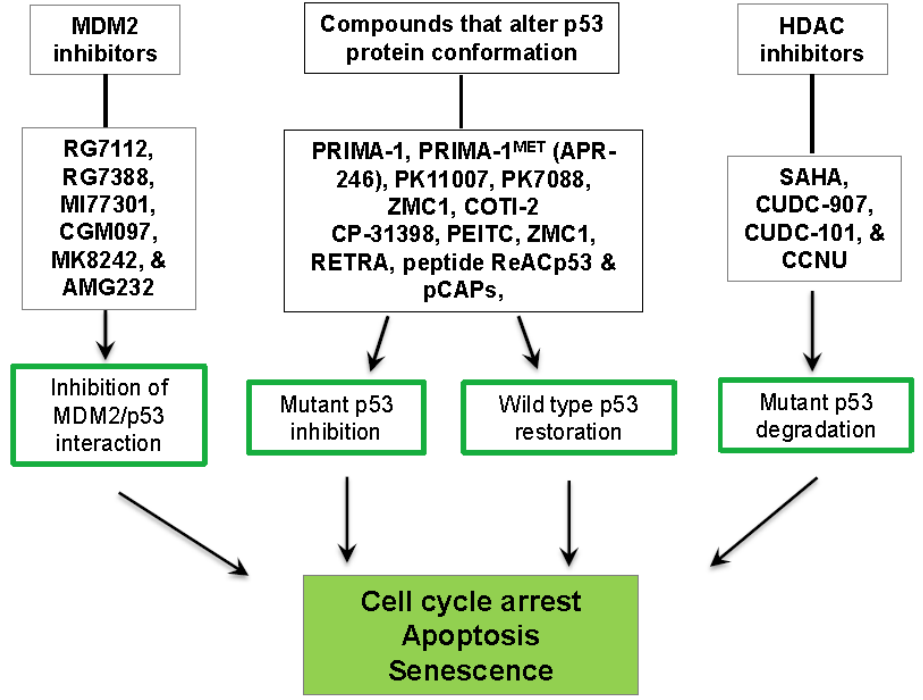
Figure 4. Summary of select strategies for the therapeutic targeting of mutant p53 in GBM. Approaches include restoration of wild type p53 activity or degradation of mutant